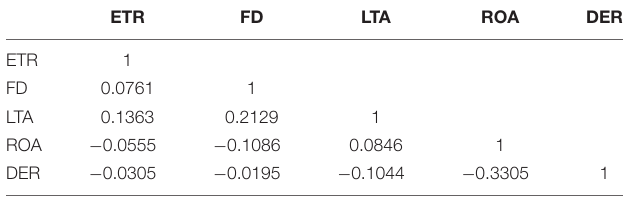
TABLE 2 | Correlation table.